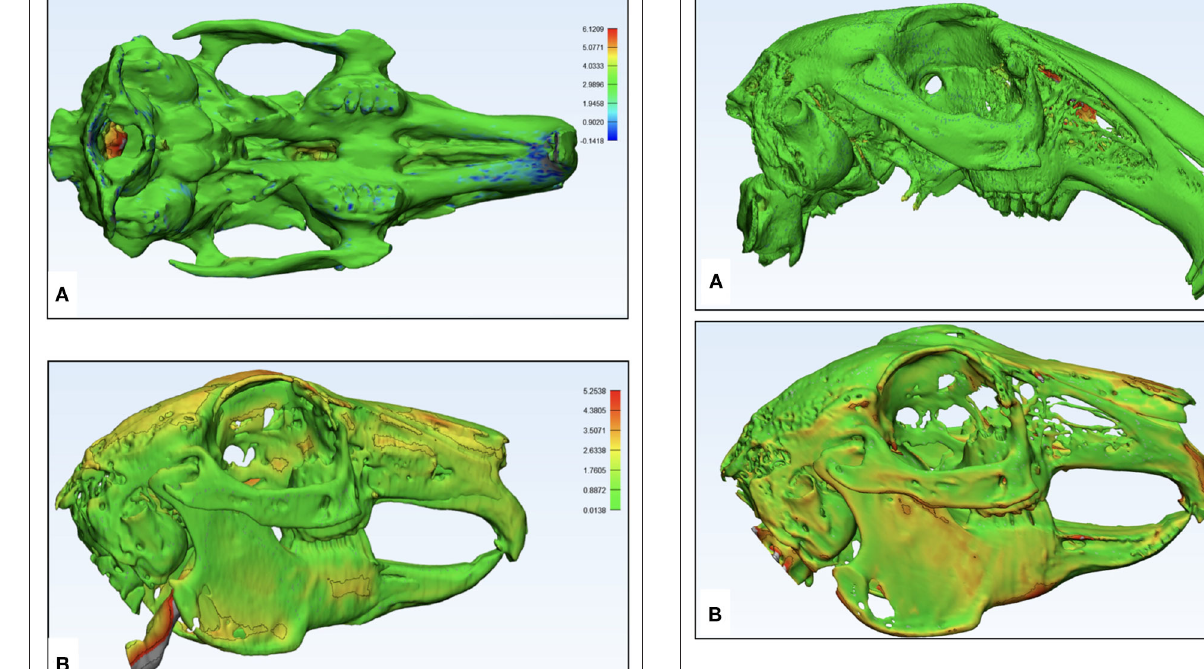
FIGURE 9 | Pictorial representation of the imaging-based printing efficiency of the polyjet printer analysis of replication of specimen anatomy on the model using Materialize 3-Matic 13.0 software. The color codes green, yellow, orange, and red signify the anatomical structures on the specimen’s skeleton accurately translated to the model, which is quantified by the side bars. (A) µ CT-based STL of specimen 1 displaying the detailed nasal anatomy not printed in the model and (B) CBCT-based STL of specimen 2 displaying most of the skeletal parts that were translated into the model. TABLE 3 | Results of quantitative radiodensity analysis using Analyze 12.0 tool